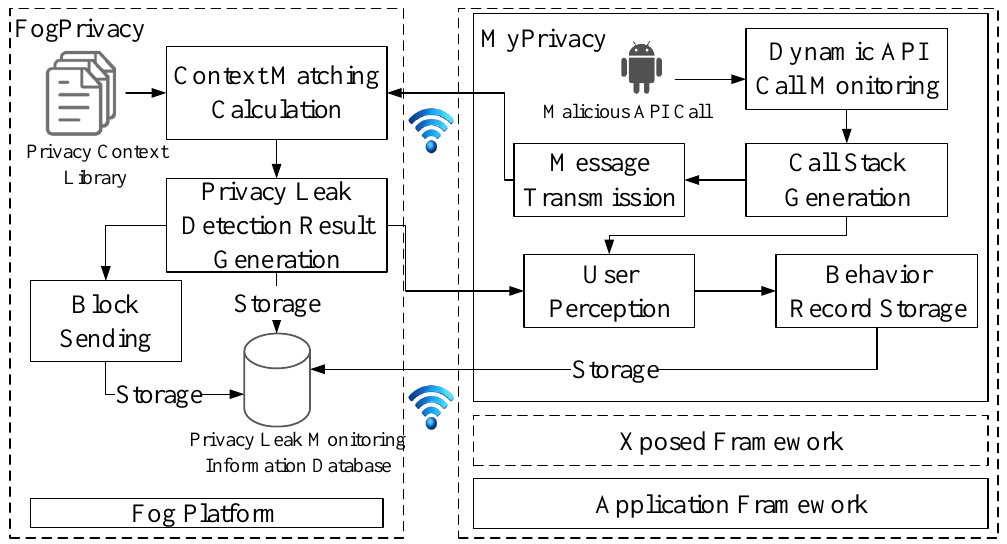
Figure 6. Dynamic privacy leakage